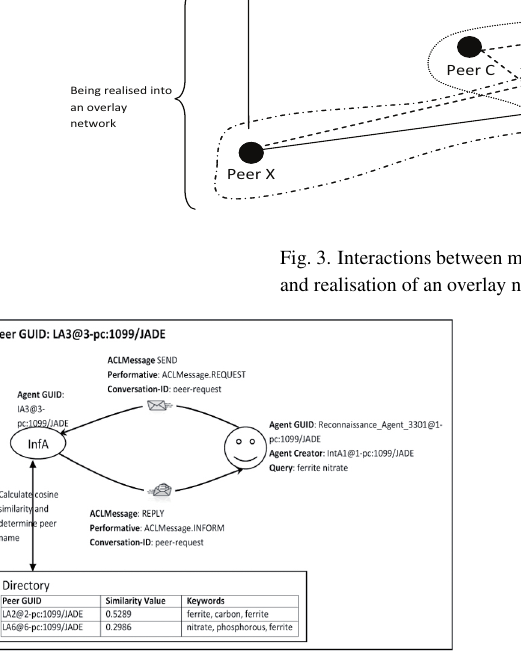
Fig. 4. The RA’s interaction with InfA for issuing new peer